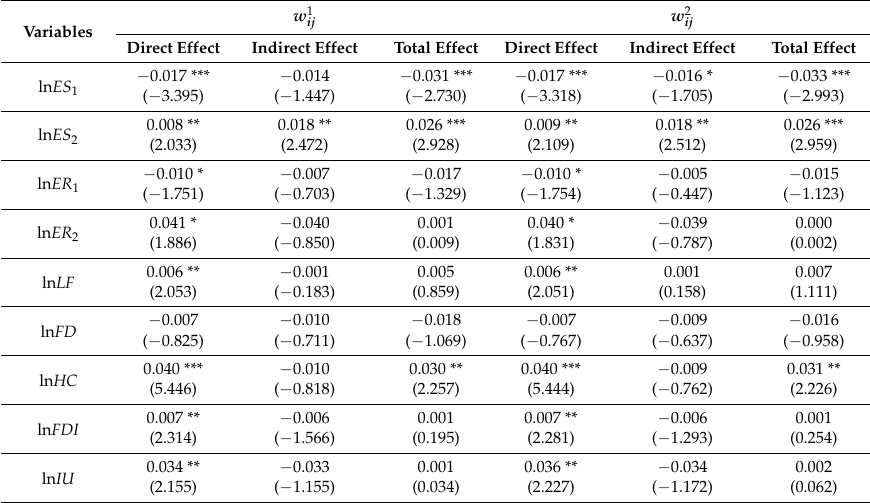
Table 7. The direct, indirect and total effects of the eastern